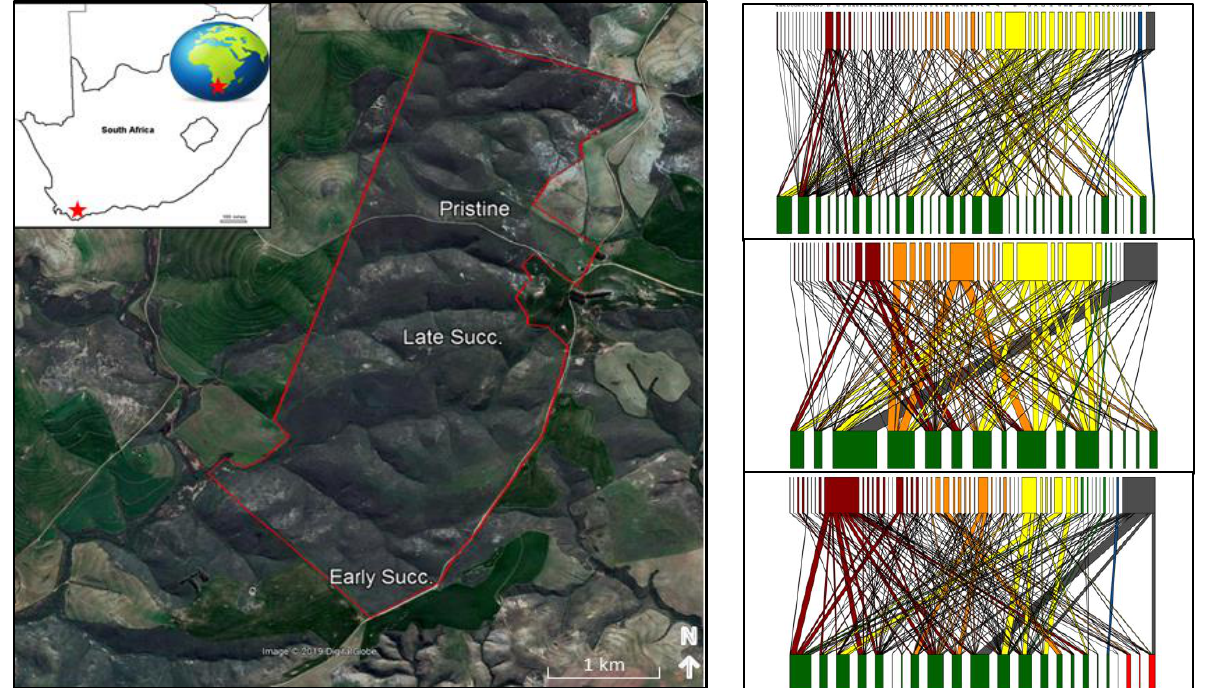
F IGURE 1: Study area showing the three study sites within Haarwegskloof Reserve (red polygon) and their associated quantitative plant- pollinator networks. Late Succ. refers to the late successional site and Early Succ. refers to the early successional site. Pollinators are shown as rectangles at the top (Red=Coleoptera, Orange=Diptera, Yellow=Hymenoptera, Green=Lepidoptera, Blue=Avis, Grey=Thysanoptera) and plants as rectangles at the bottom (red rectangles depict alien plant species). Detailed networks with species names are supplied in Appendix